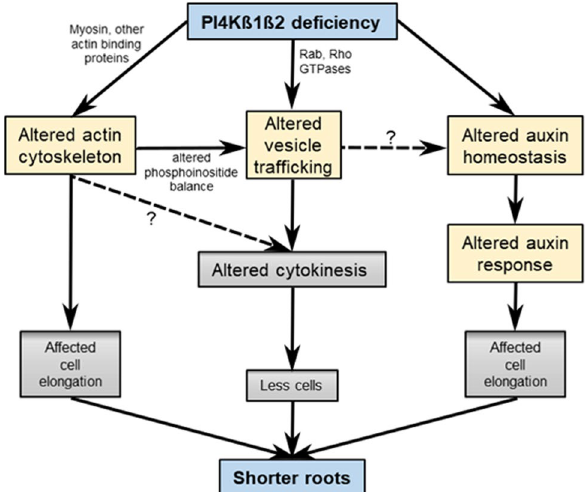
Figure 7. Working model for the impact of pi4kß1ß2 mutations on root length. The pi4kß1ß2 mutations lead to an altered actin cytoskeleton, an altered vesicle trafficking and an altered sensitivity to auxin including at the gene expression level. Altered trafficking can be linked to PI4K interacting with small G proteins like Rab or Rho proteins; it could also be a consequence of the weakened cytoskeleton. It is hypothesized that both altered cytoskeleton and trafficking prevent a correct cytokinesis. Finally, we propose that the short root phenotype results from multiple causes: altered actin cytoskeleton, altered cytokinesis, altered trafficking, and altered auxin